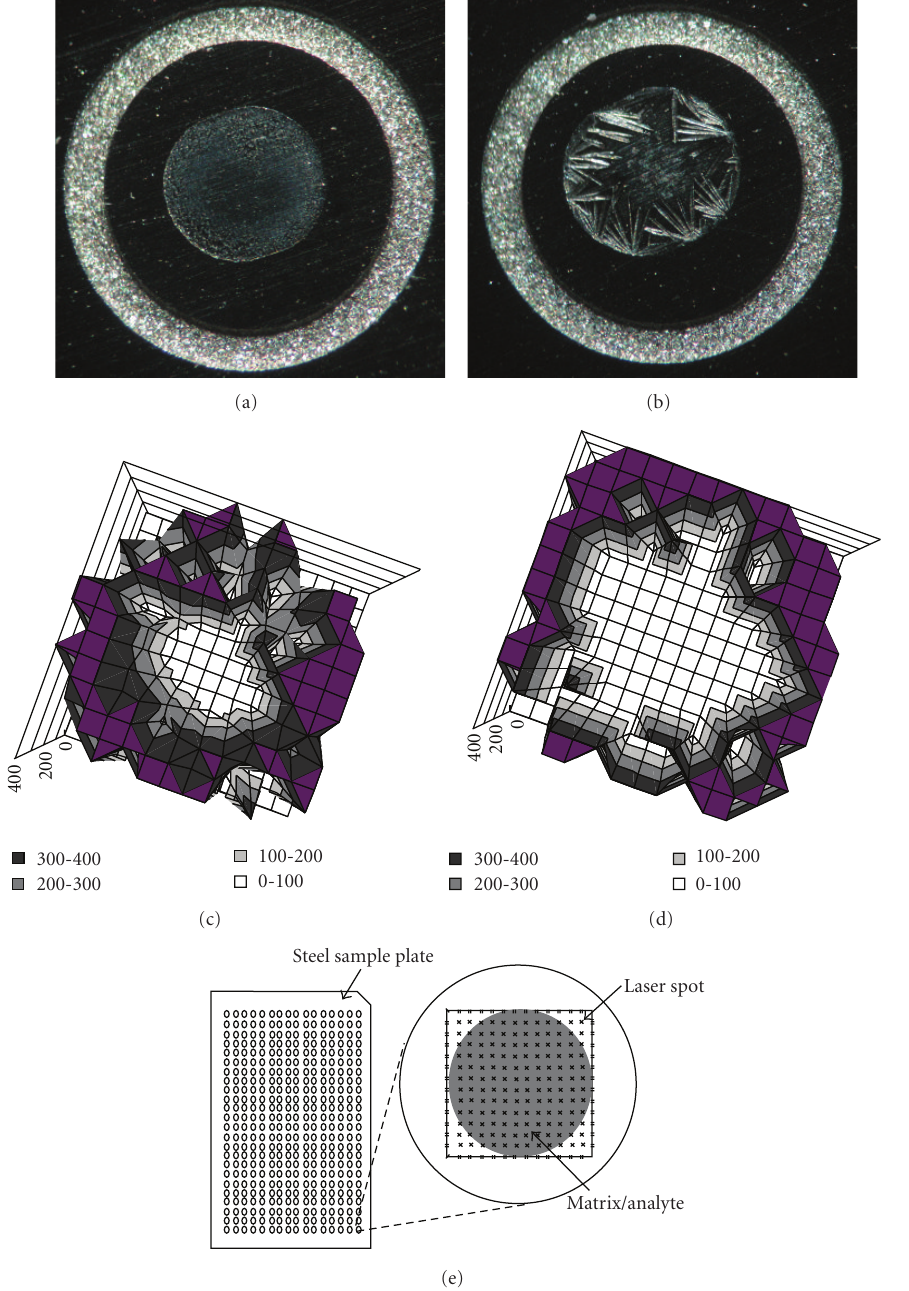
Figure 2: Top two views show the MALDI samples containing the phosphopeptide p T using (a) DHAP/DAHC matrix and (b) DHB/PA matrix. The two center pictures show the signal intensities of the phosphopeptides p T (250 fmol on target) measured with (c) DHAP/DAHC matrix and (d) DHB/PA matrix. The images only show a cut at signal intensity of 400 mv for clarity. The positions with signal intensities above 400 mv are indicated in purple. The bottom row (e) shows a schematic of the data acquisition method for investigating sample homogeneity of the matrix. In total, 196 positions were selected as a 14 × 14 spots array to cover the crystalline matrix/analyte layer, and 50 profiles (5 shots per profiles) were accumulated at each